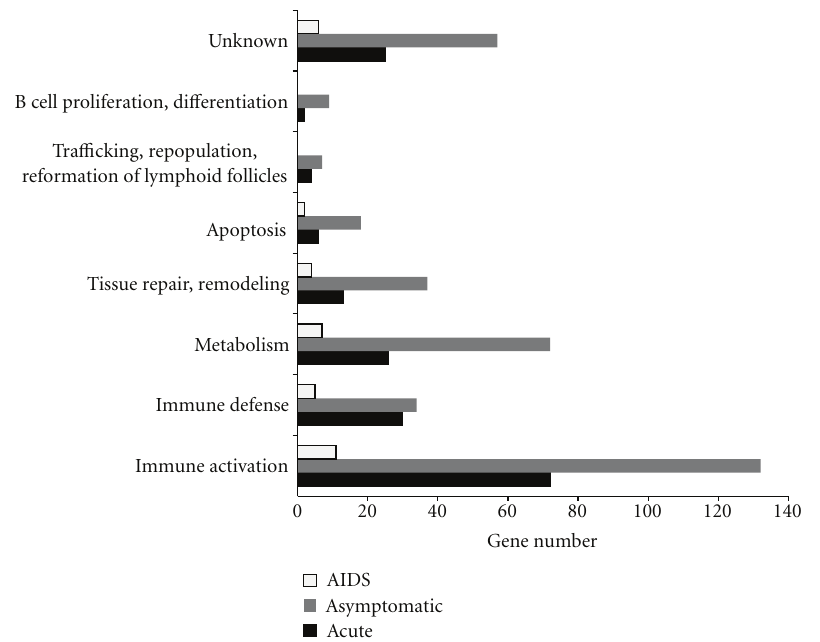
Figure 5: Functional categories of genes with significant Δ G + or Δ G − between GCNs of the uninfected subjects and HIV-1 patients at three di ff erent stages (acute, asymptomatic, and